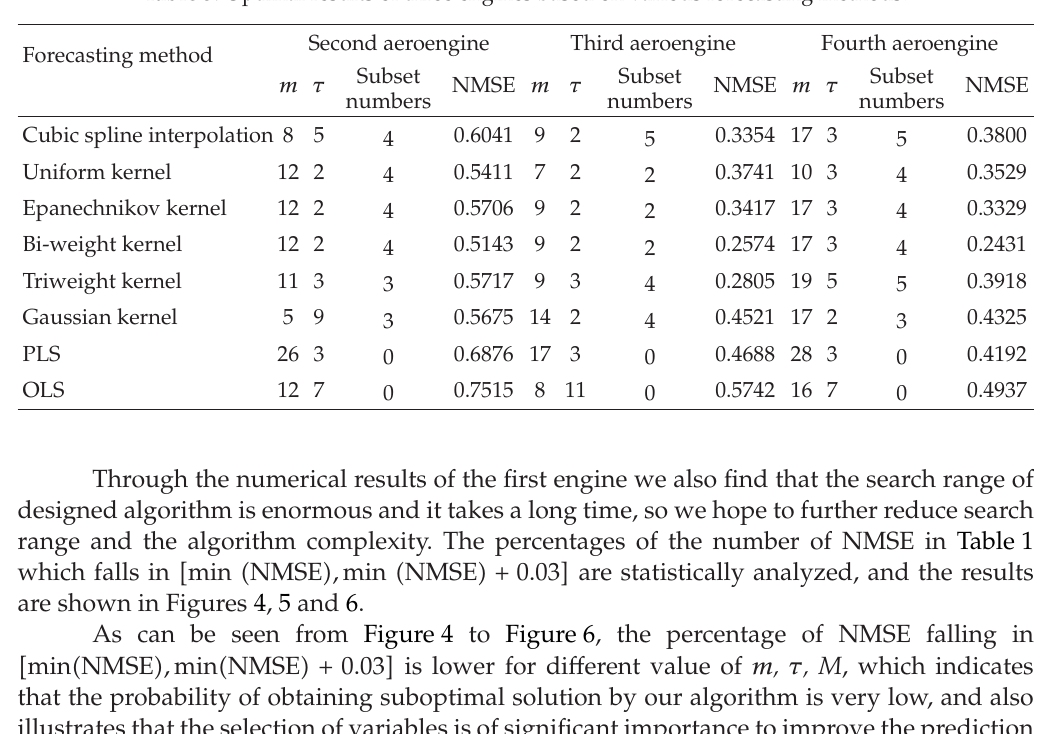
Table 3: Optimal results of three engines based on various forecasting